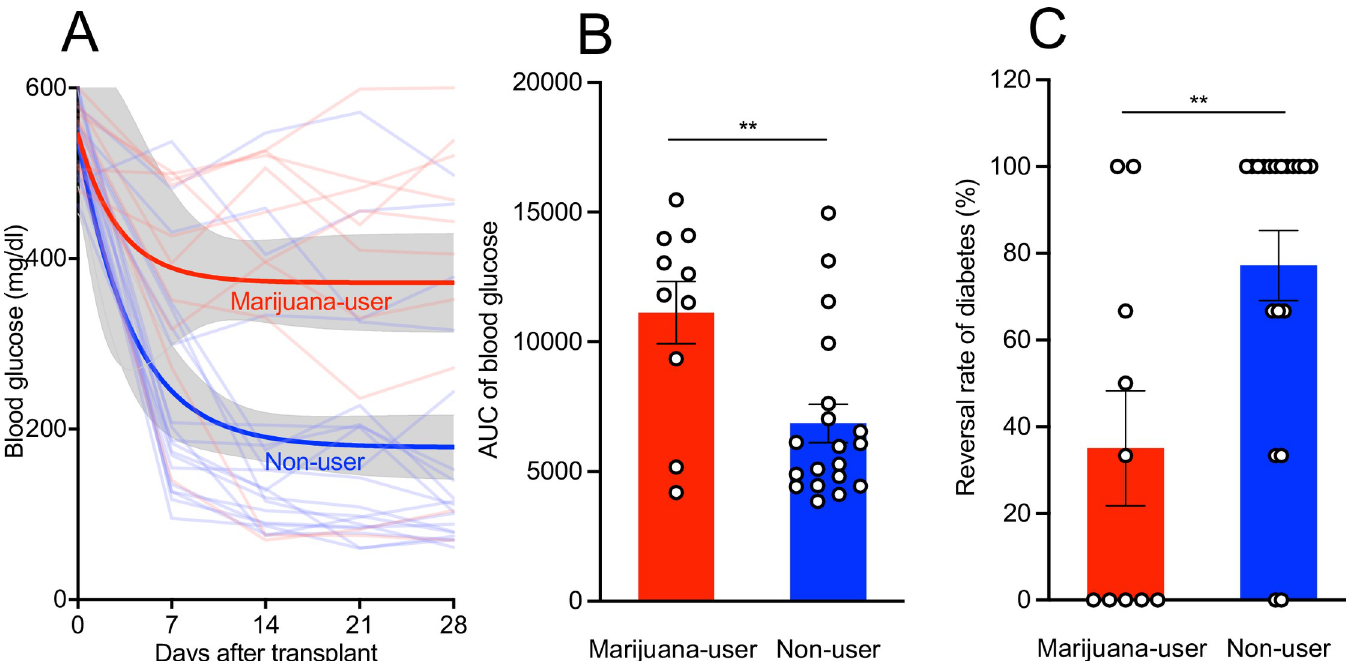
Fig 2. Islets from chronic marijuana-users have diminished graft function following transplantation into diabetic NOD SCID mice. Isolated islets (1,200 IEQ) from non-users and marijuana-users were transplanted beneath the renal capsule of the left kidney of diabetic NOD SCID mice. (A) Blood glucose levels were determined periodically for 28 days post-transplantation. The highlighted areas are the range of standard error of mean of each donor group. (B) Calculated area under the curve of blood glucose levels, marijuana-user (n = 30 mice received human islets from 10 donors); non-user (n = 50 mice received human islets from 19 donors). Each dot in the bar graph represents the average AUC of blood glucose from all the mice transplanted with islets from a single donor. (C) The mean reversal rate of diabetes in the mice after islet transplantation. For each batch of islets isolated from a single donor, the ratio of the number of mice that reversed diabetes divided by the total number of mice transplanted was calculated. Then the mean reversal rates of diabetes were averaged from marijuana-users (10 donors) and non-users (19 donors). Each dot in the bar graph represents the reversal rate of diabetes in single donor. �� p < 0.01. All analyses were performed using GraphPad Prism version 8.0. A p < 0.05 was considered significant. The values were expressed as the mean ±